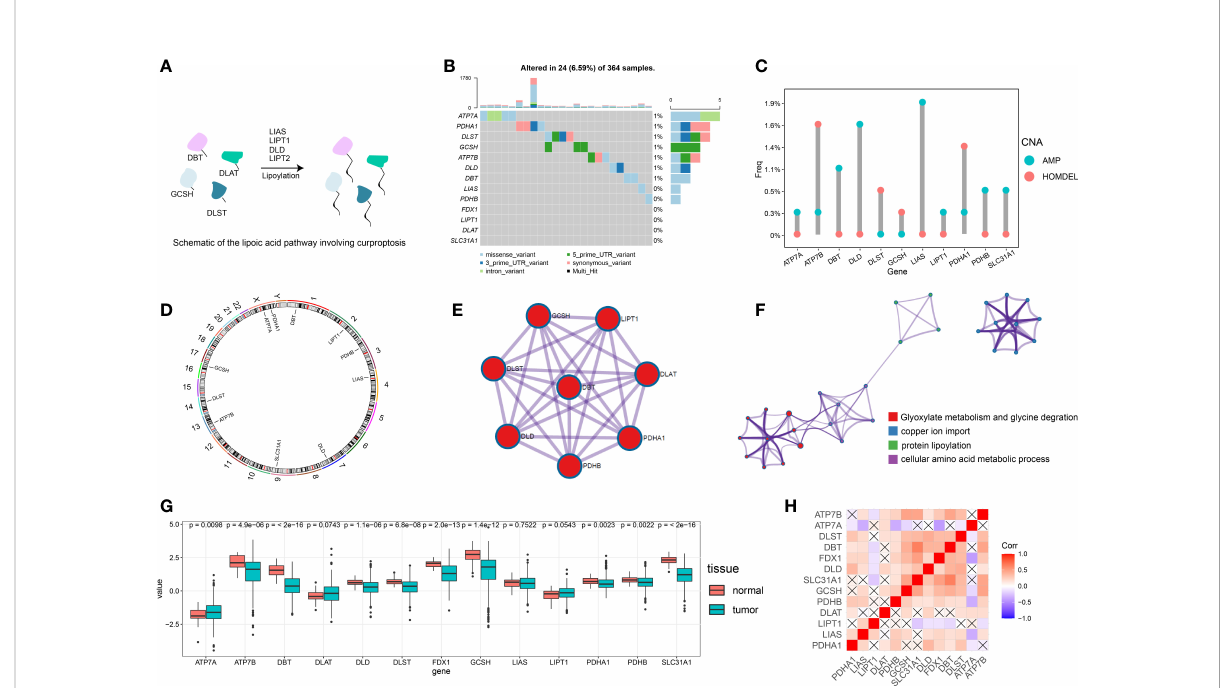
FIGURE 1 Overview of the multi-omics analysis for cuproptosis. (A) Schematic diagram for the lipoic acid pathway involving cuproptosis. (B) Of the 364 patients with HCC, 24 (6.59%) showed gene mutations in 13 cuproptosis-related genes, primarily including missense variants, 5 ’ UTR variants and synonymous variants. (C) The CNV mutation was prevalent in cuproptosis-related genes. Columns represent the alteration frequency, blue dots the ampli fi cation frequency and red dots the deletion frequency. (D) Location of the CNV alteration in cuproptosis-related genes on the chromosome. (E) Protein-protein interactions of cuproptosis-related genes. (F) Metascape network visualization showing enrichment pathway terms. Cluster annotations are color coded. (G) Differences in gene expression levels for each cuproptosis-related gene between normal and tumor tissues. (H) Visualization of the gene correlation matrix. “ X ” represents a lack of statistical signi fi